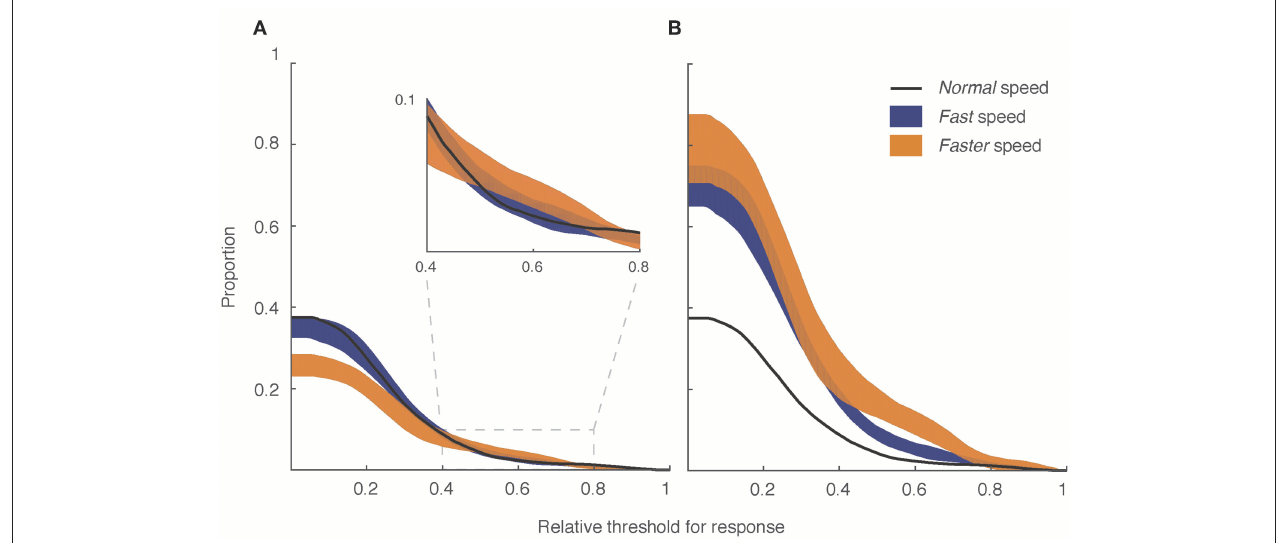
FIGURE 8 | Signaling faster improves the salience of signal movements compared with plant movements, but reduces the time-frame over which the signal can be detected. The plots show the proportion of the lizard display with salience scores exceeding receiver thresholds for response in moderate wind (level 6) and luminance contrast (level 4). In each plot, the normal speed sequence (black line) is compared with the set of sequences in which display speed was increased by 1.5 × (blue; fast ) and 2.0 × (orange; faster ) the normal speed. The shaded regions for the fast and faster sequences represent the minimum and maximum values for a given threshold. (A) Data is shown using the full 8s sequence duration, with the reduction in performance for the fastest display movements a consequence of reduced time in motion. Despite this, the faster sequence was more effective at mid-high thresholds (see inset). (B) Data are shown as a function of time in motion and shows that both fast and faster movements are more salient than normal speed.